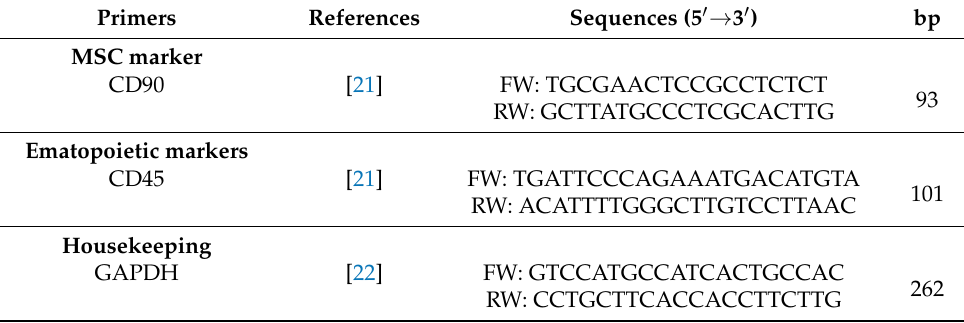
Table 2. Primers sequences for PCR analysis.